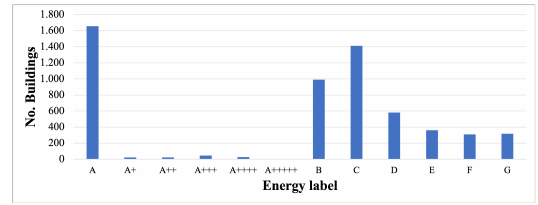
Figure 7. Buildings per energy label class in Rijssen-Holten